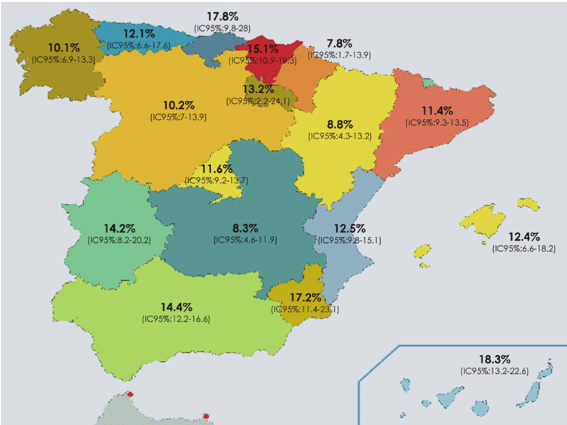
Figure 1: Regional migraine prevalence rates found in Spain (from 9). Galicia (10.1%), Asturias (12.1%), Cantabria (17.8%), Euskadi (15.1%), Navarra (7.8%), Catalonia (11.4%), Rioja (13.8%), Castilla- Leon (10.2%), Aragon (8.8%), Madrid (11.6%), Extremadura (14.2%), Castilla-La Mancha (8.3%), Valencia (12.5%), Baleares Islands (14.4%), Murcia (17.2%), Andalusia (14.4%), and Canary Islands